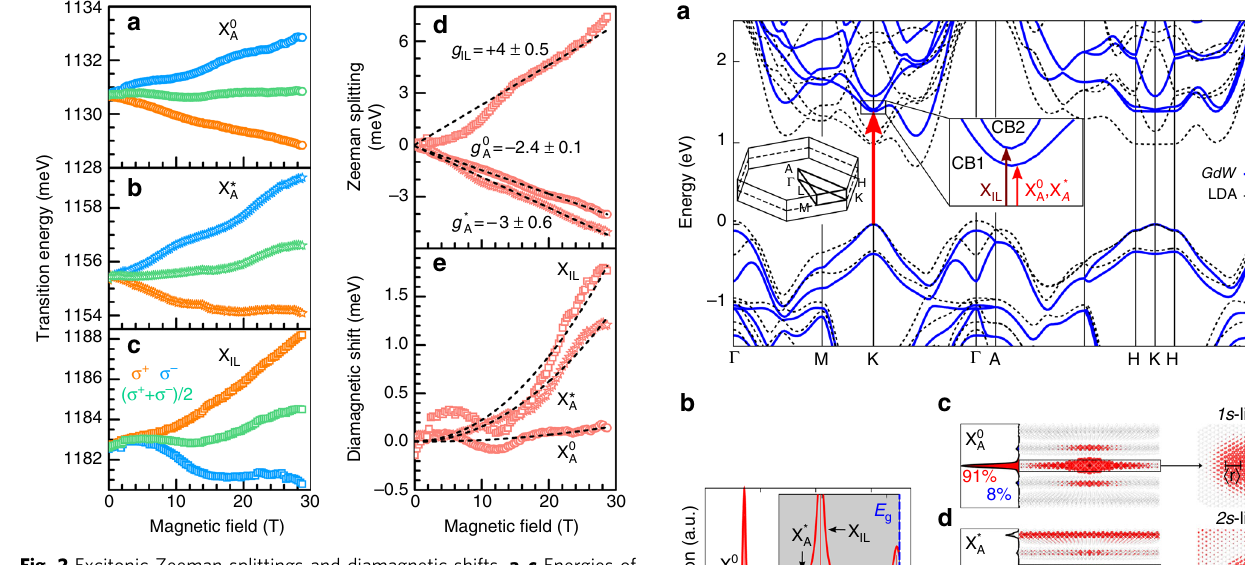
Fig. 2 Excitonic Zeeman splittings and diamagnetic shifts. a – c Energies of the circularly polarized σ + ( blue ) and σ − ( orange ) optical transitions of the three exciton resonances X 0 , X (cid:1) , and X IL derived from the μ RC spectra. A A Energies obtained by calculating the arithmetic mean of the blue and orange data are shown in green . d Zeeman splittings for the exciton resonances ( red points ). Note the reversal of the sign of the effective g -factor in d for the interlayer exciton X IL . e Diamagnetic shifts with fi ts to the data ( dashed lines ) Fig. 3 Calculated exciton absorption spectra and spatial distributions. a LDA (local density approximation) ( dashed line ) and quasiparticle band structure in the GdW approximation ( solid blue line ) of bulk MoTe 2 . Vertical arrows indicate the largest contributions from the bands to the X 0 X IL excitations at the K point. The left inset shows the three-dimensional Brillouin zone. b Calculated exciton absorption spectrum using a linewidth broadening of 2 meV with a zoomed-in view on the X (cid:1) The dashed blue line at 1.385 eV indicates the direct band gap at K. c Side view ( left ) and top view ( right ) of the spatial distribution of the